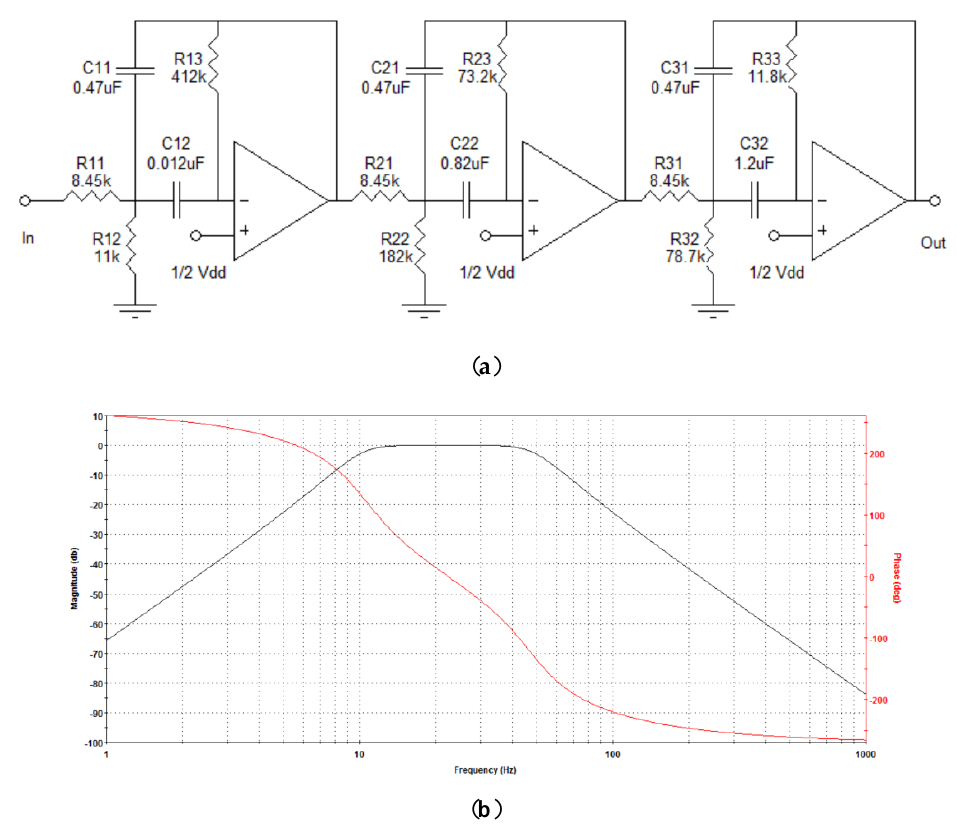
Figure 3. Example of a bandpass filter: ( a ) bandpass filter circuit diagram; ( b ) frequency response